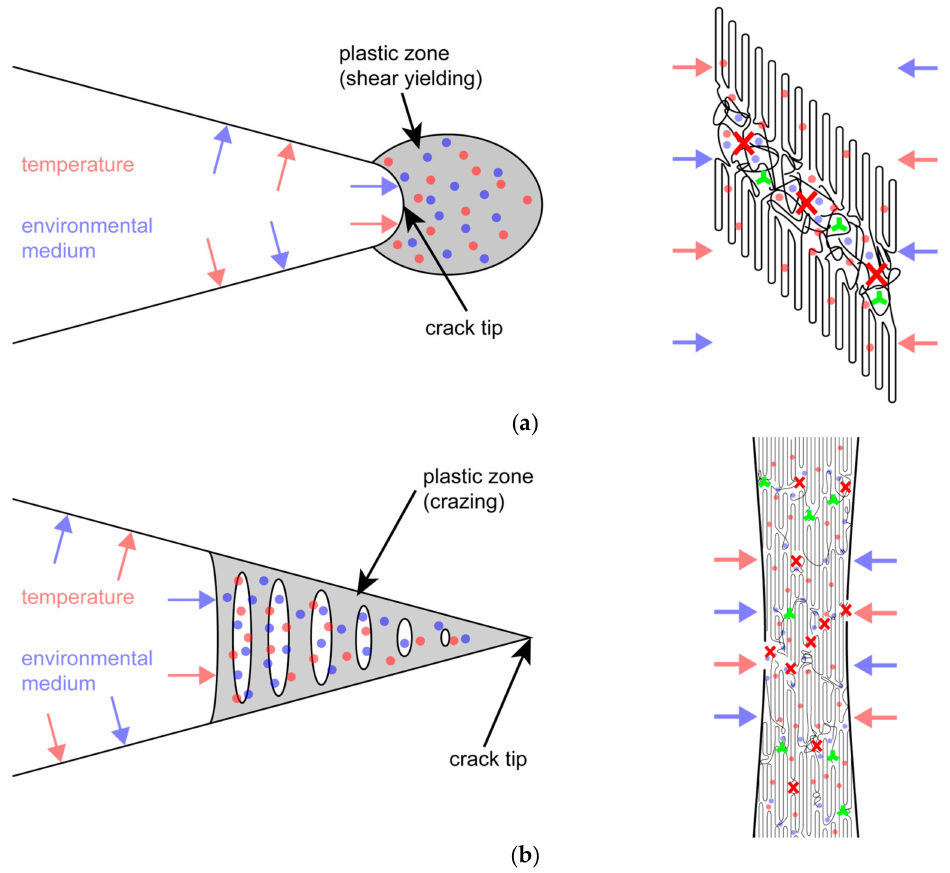
Figure 9. Schematic illustration of the crack tip region under superimposed mechanical-environmental loading (red arrows and dots representing temperature, blue arrows and dots representing environmental liquid, green stars representing stabilizer molecules, red crosses representing molecular chain scission). ( a ) Plastic deformation by shear yielding with the crack tip shear yield zone ( left ) and irreversible shear deformation of semi-crystalline lamellar structure ( right ). ( b ) Plastic deformation by crazing indicating the wedge-shaped fibril / void structure of a crack tip craze ( left ) and a highly stretched semi-crystalline craze fibril ( right